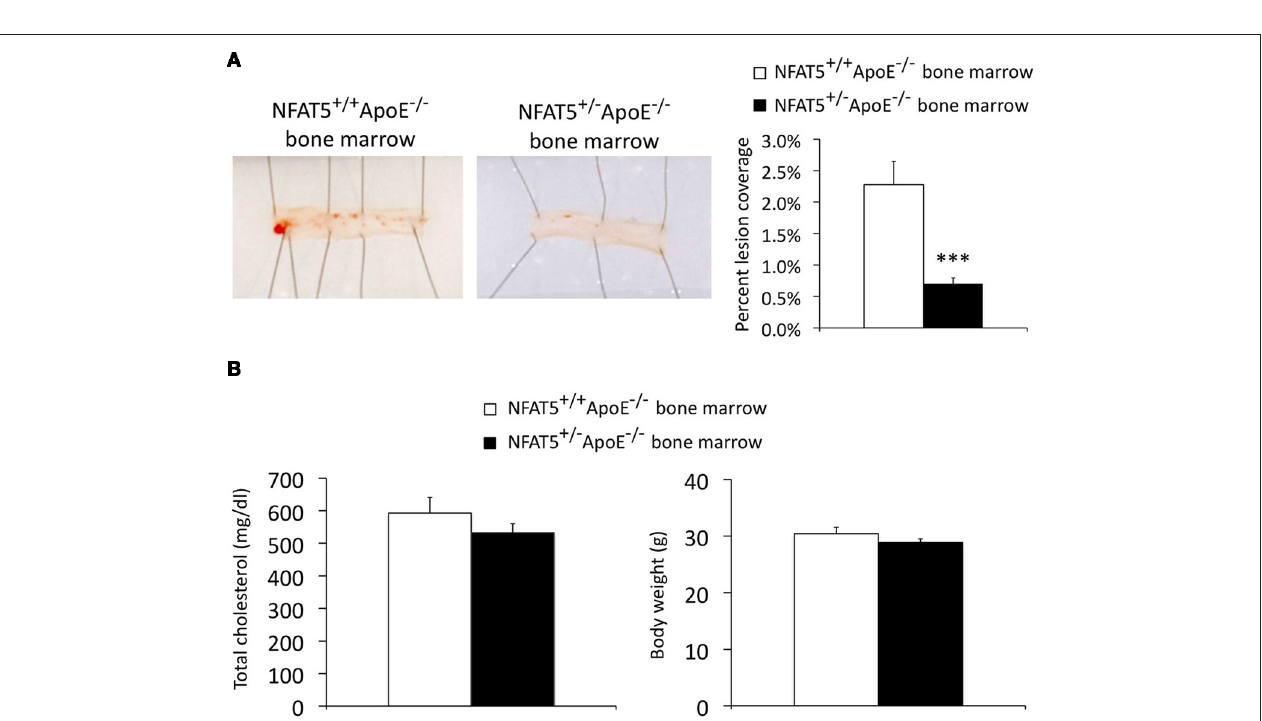
FIGURE 3 | Immunohistochemical quantification of aortic arch lesions does not reveal a discernable difference in smooth muscle cell or macrophage investment of the lesion. Immunohistochemicalanalysis of